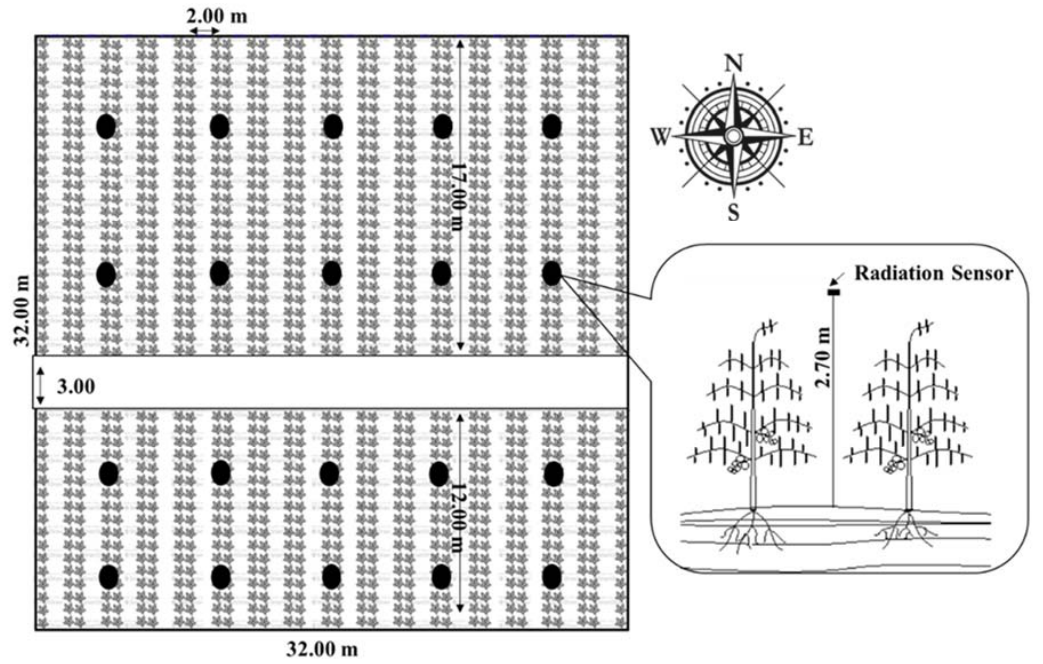
Figure 1. Location of sample points inside the greenhouse.